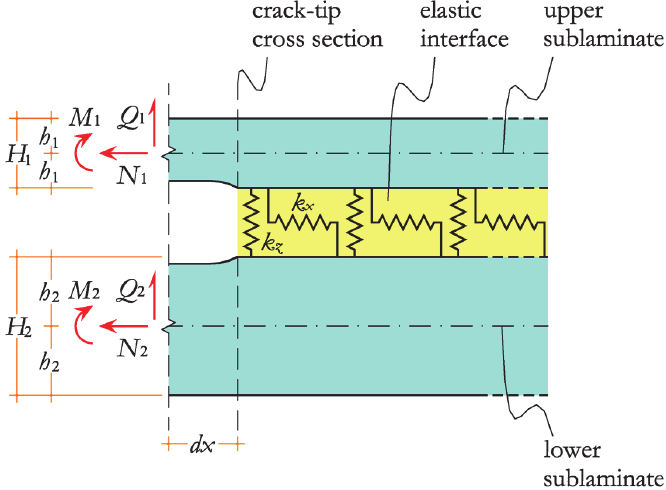
Figure 7: Elastic-interface model of a delaminated